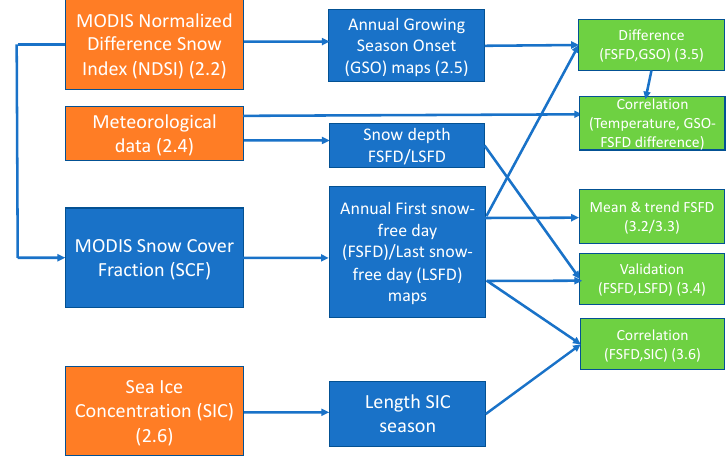
Figure 2. Overview of the research scheme and datasets and methods used in this study. Orange components refer to datasets, blue boxes indicate derived products and green boxes are end results.